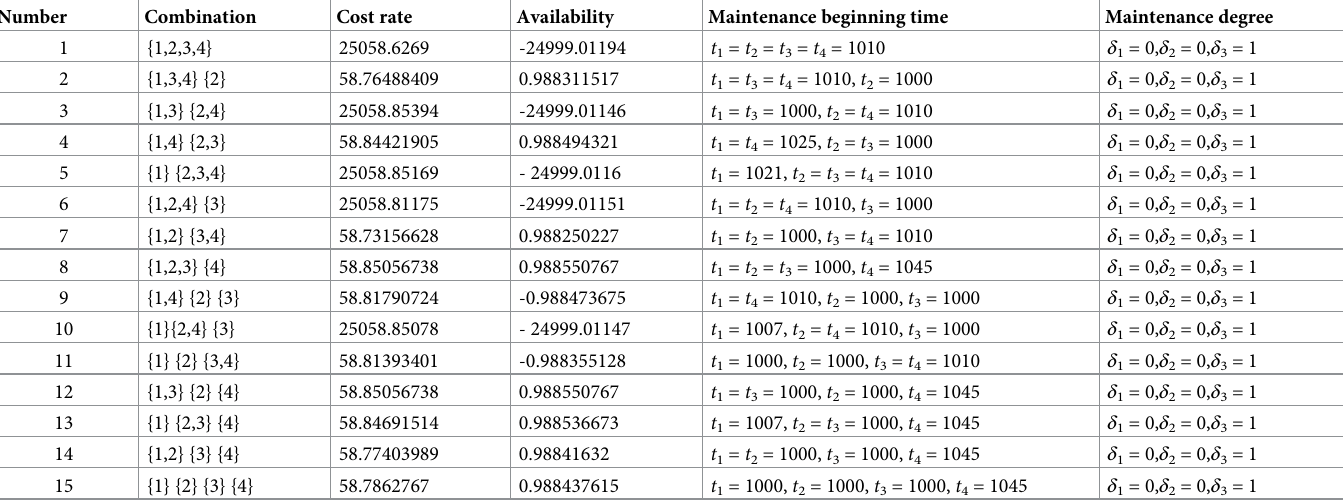
Table 4. Optimization results analysis when follow-up maintenance cost and downtime is large.